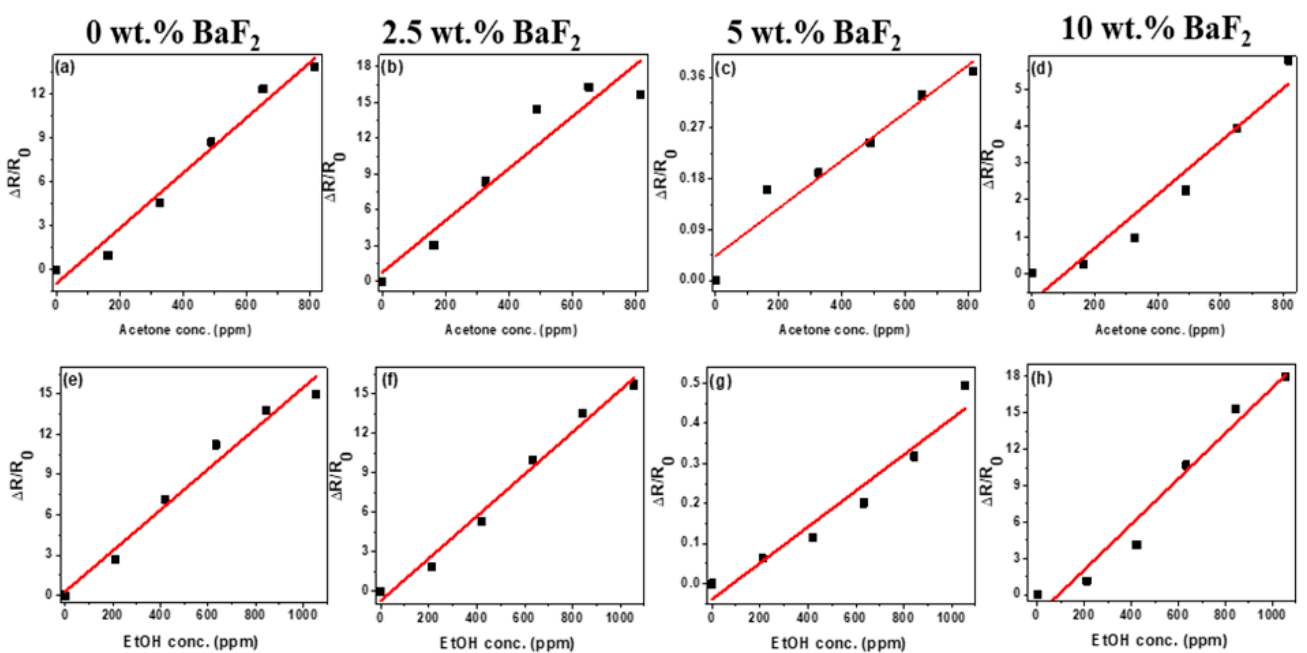
Figure 5: Sensor response versus concentrations of ( a – d ) acetone and ( e – h ) ethanol at optimum operating frequencies.